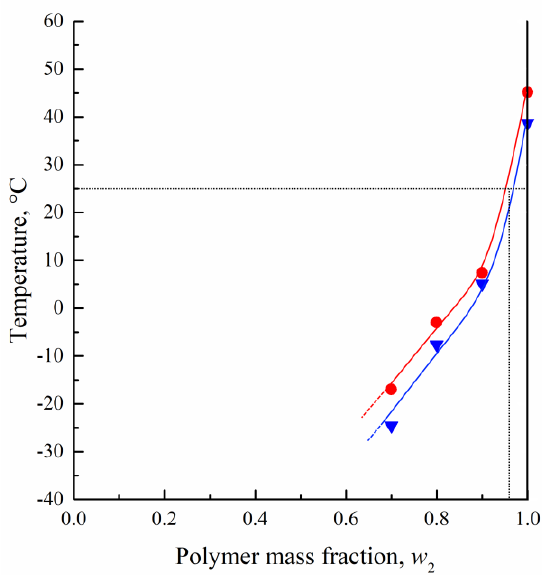
Figure 3. Glass transition temperature T g of PLGA/TG mixture samples as a function of their PLGA content, determined by the DSC method during the first cooling (blue triangles) and second heating (red circles) sessions.